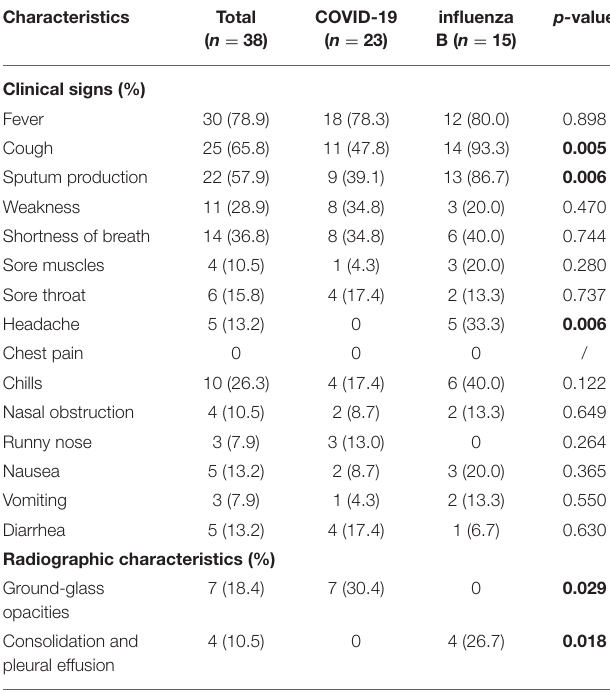
TABLE 4 | Clinical symptoms of patients with COVID-19 and influenza-B.